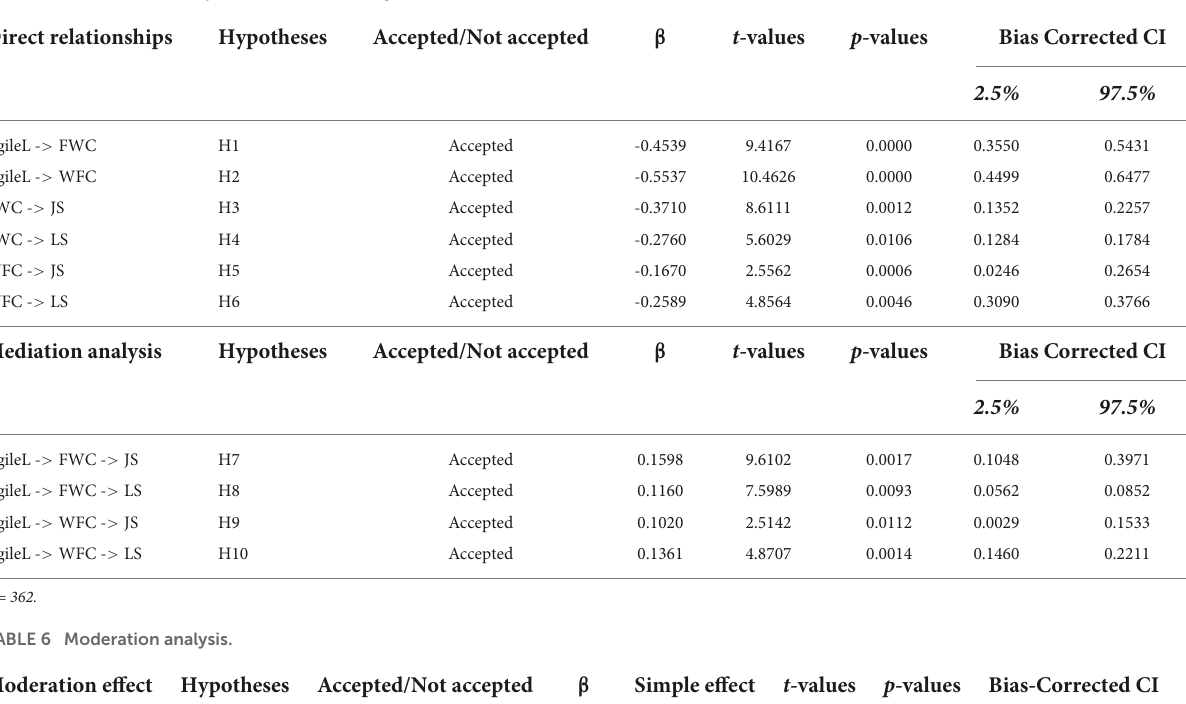
TABLE 5 Direct relationships and mediation analysis. Direct relationships